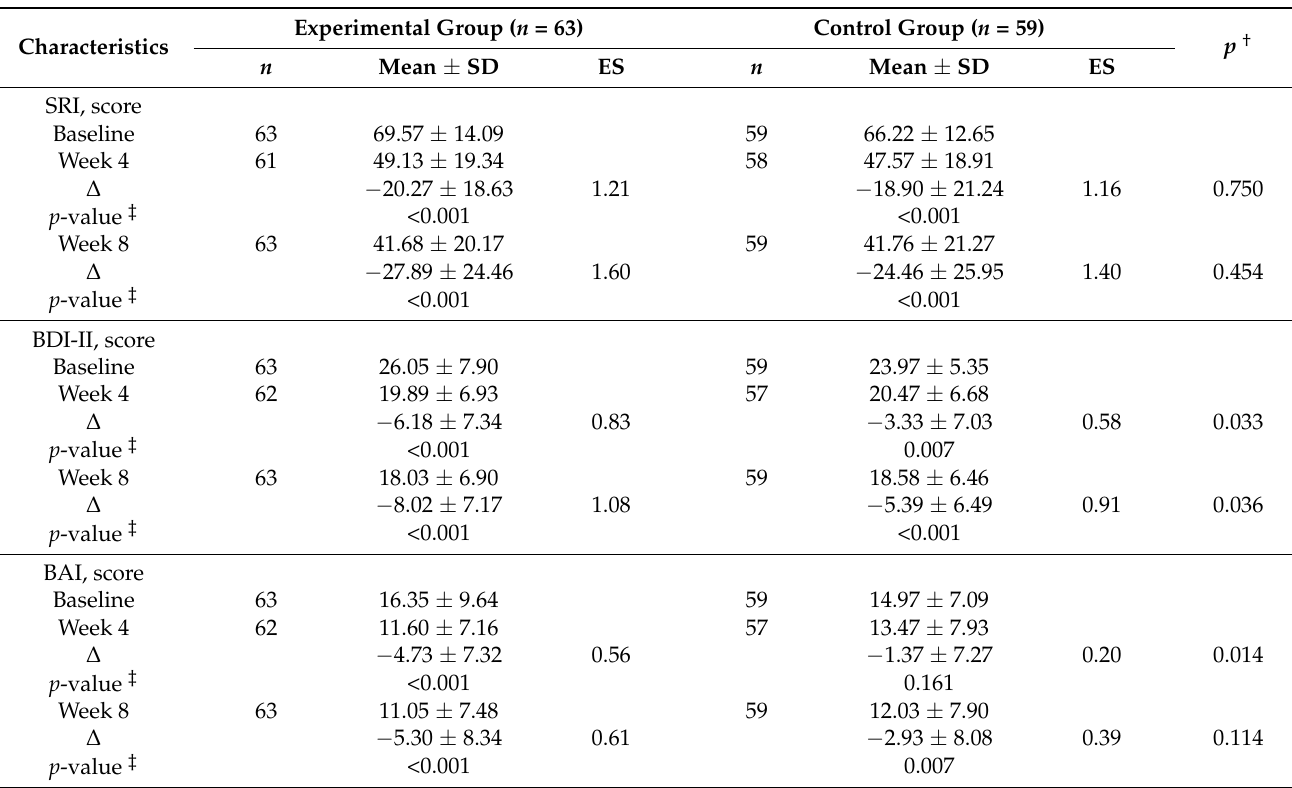
Table 2. Comparison of the changes in mood parameters from baseline to four and eight weeks of intervention between the two study